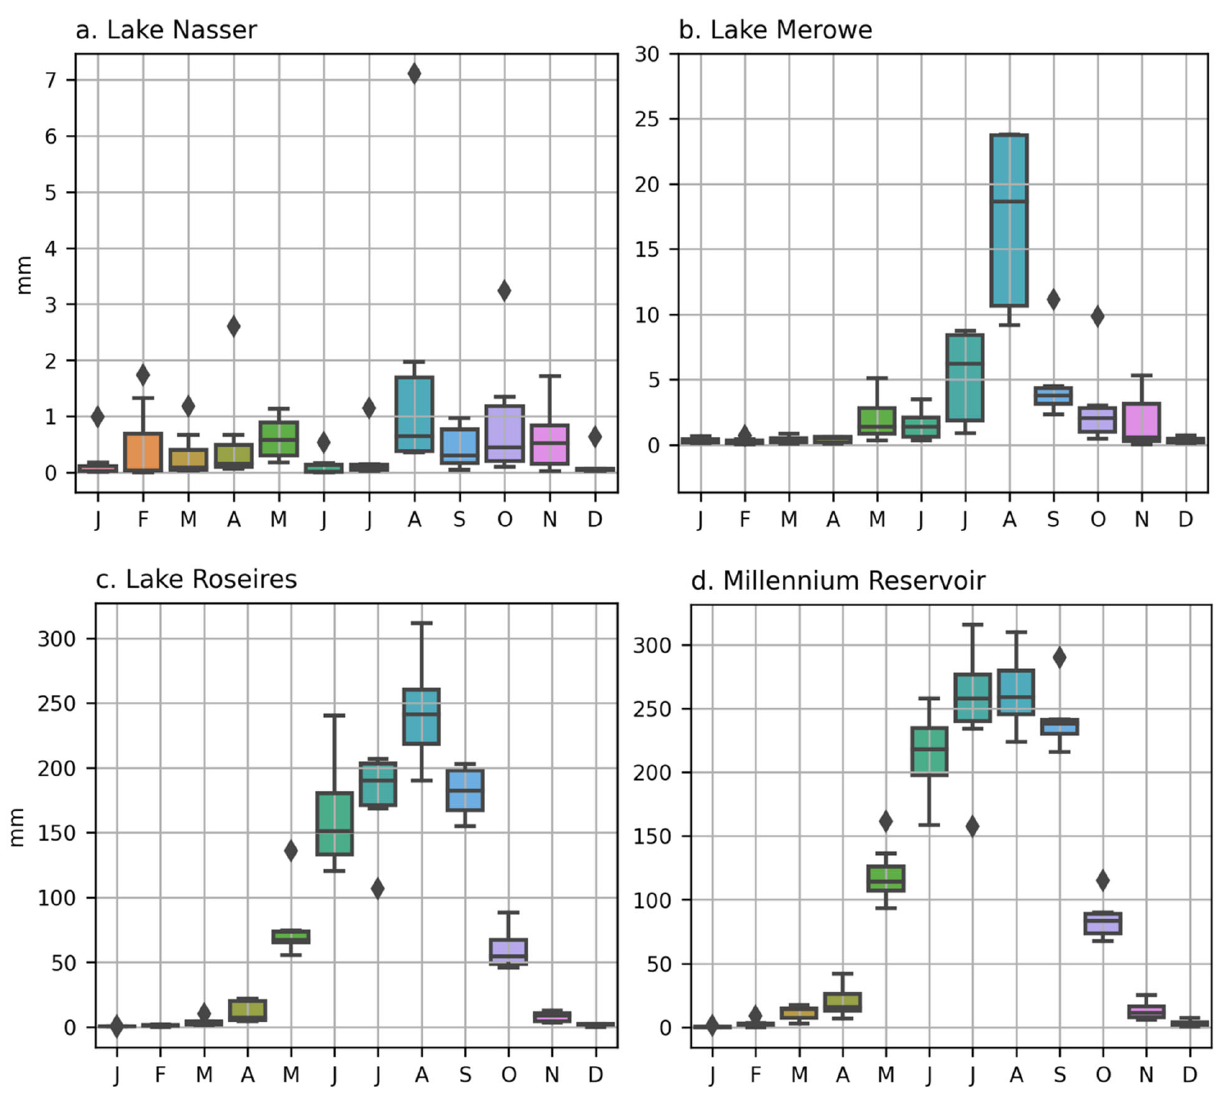
Figure 2. ( a – d ): Monthly boxplots of rainfall variation over the four reservoirs. The rainfall data were obtained from the GPM IMERG V6 Final Run product over the bounding box region of each reservoir. The diamonds represent the outliers beyond 95th percentile of the data.